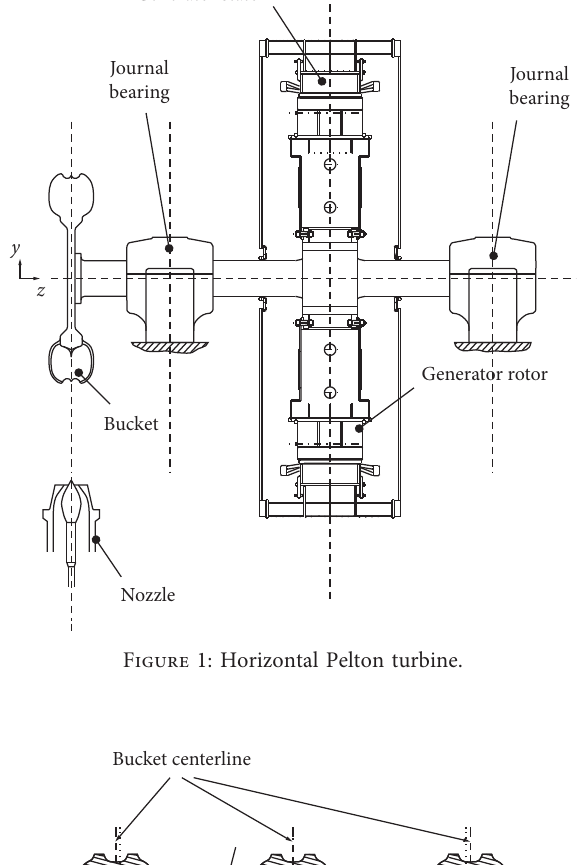
Figure 1: Horizontal Pelton turbine.